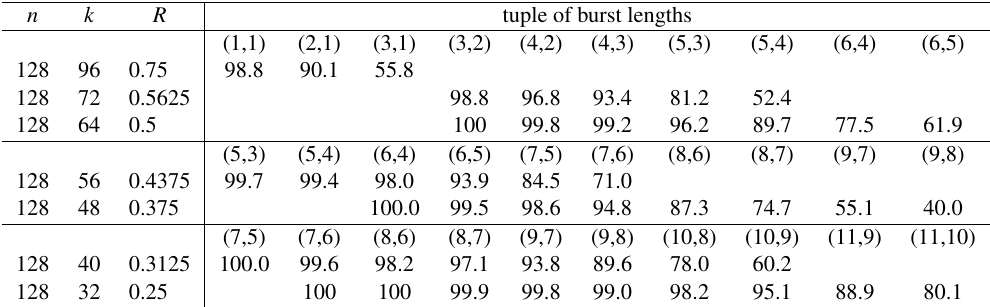
Table 1. Correcting capabilities (%) measured by the ratio of frames which are able to be corrected. The burst length corresponds to the definition given in Eq.